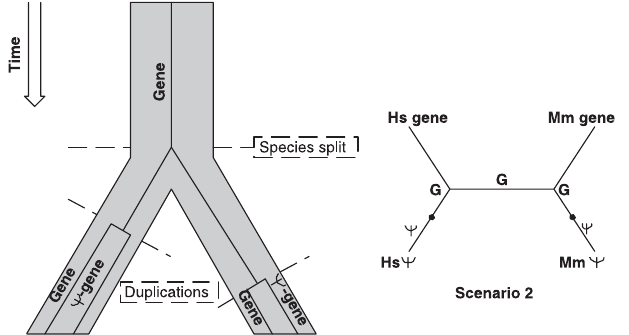
Figure 2. Evolutionary Scenario S 2, Describing the Common Case of Late and Independent Pseudogene Origin DOI: 10.1371/journal.pcbi.0020046.g002